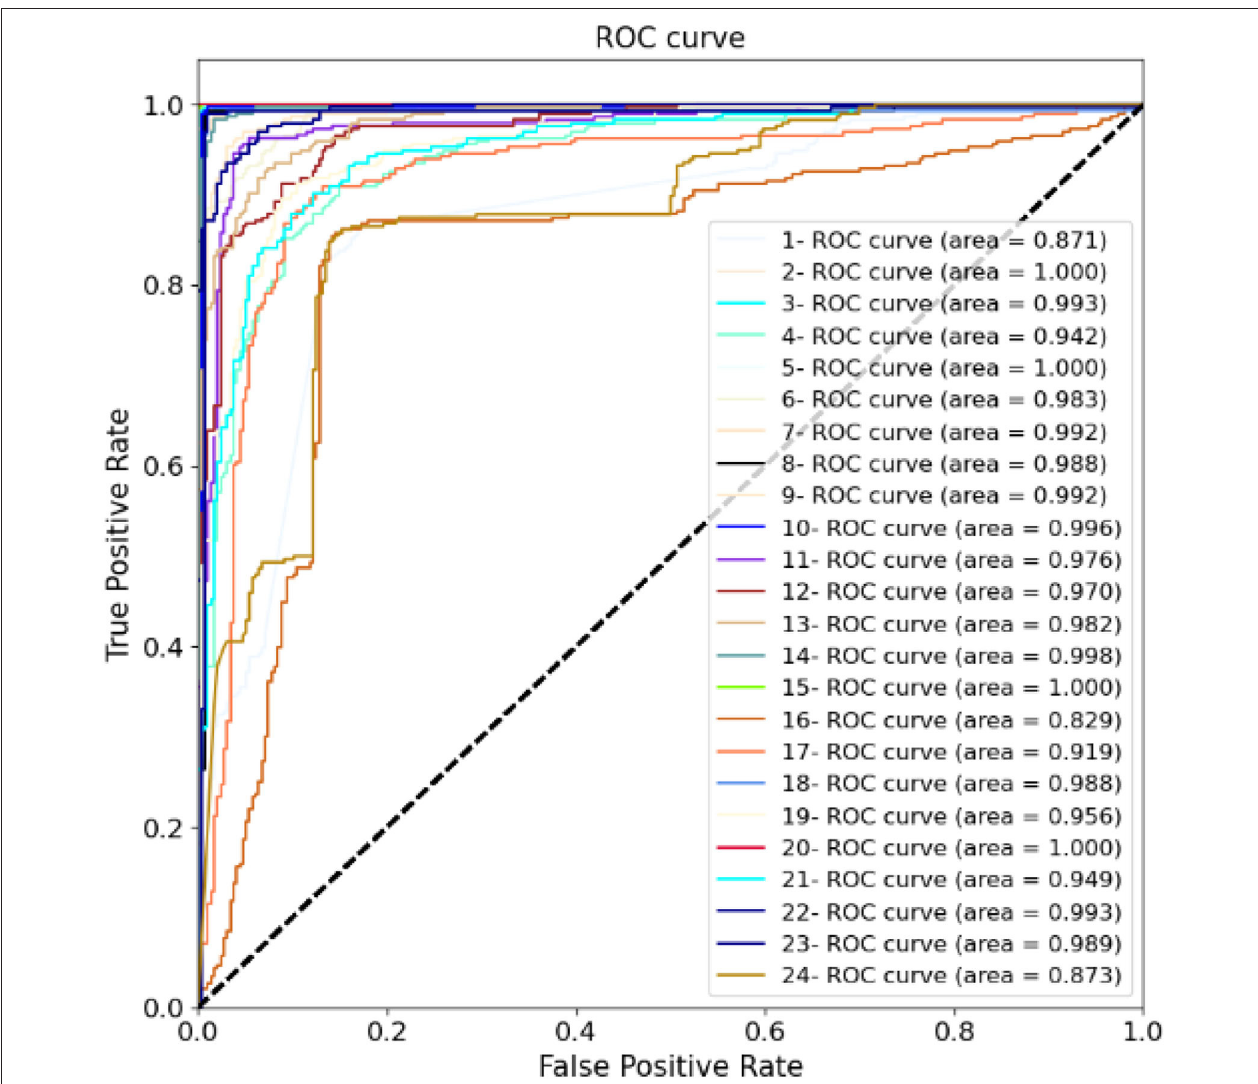
FIGURE 9 | Twenty-four-fold cross-verified ROC curves and areas.